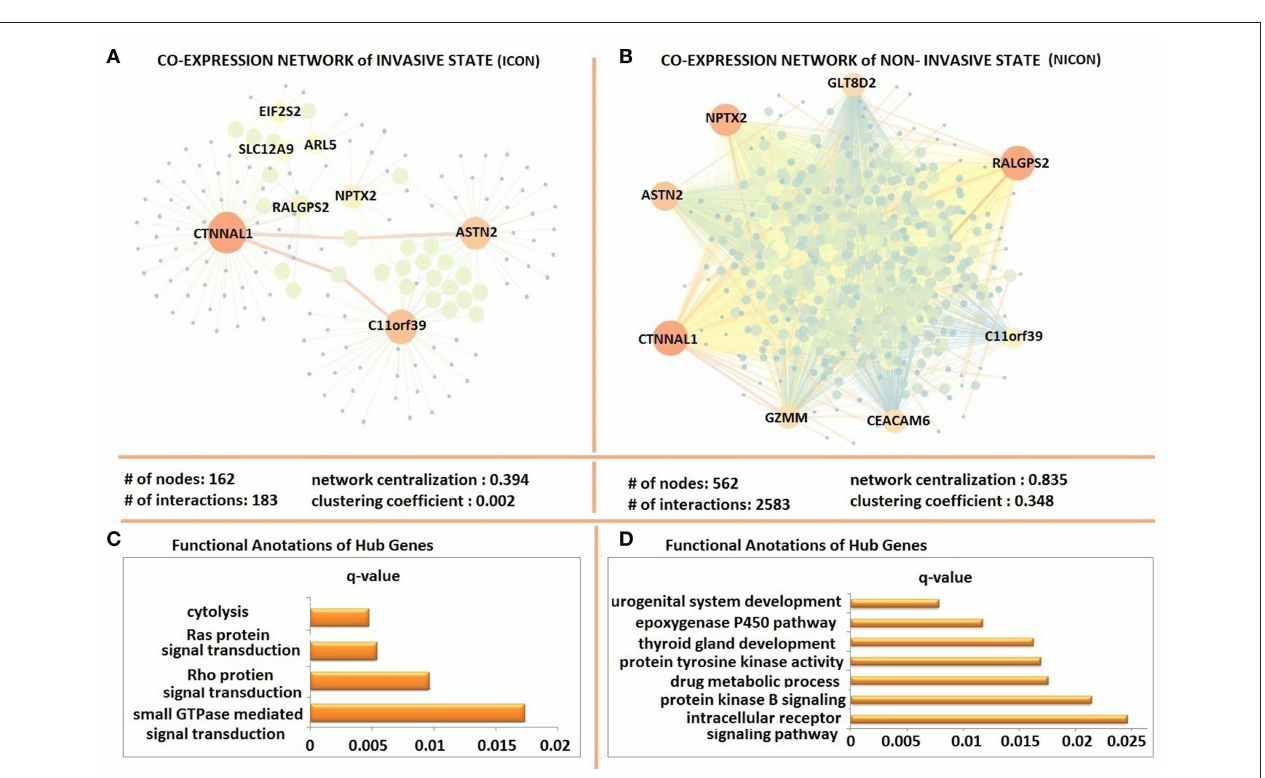
only the number of genes exhibiting co-expression pattern was almost 4-fold higher in the non-invasive state, but also the network centralization (0.835) and the clustering coefficient